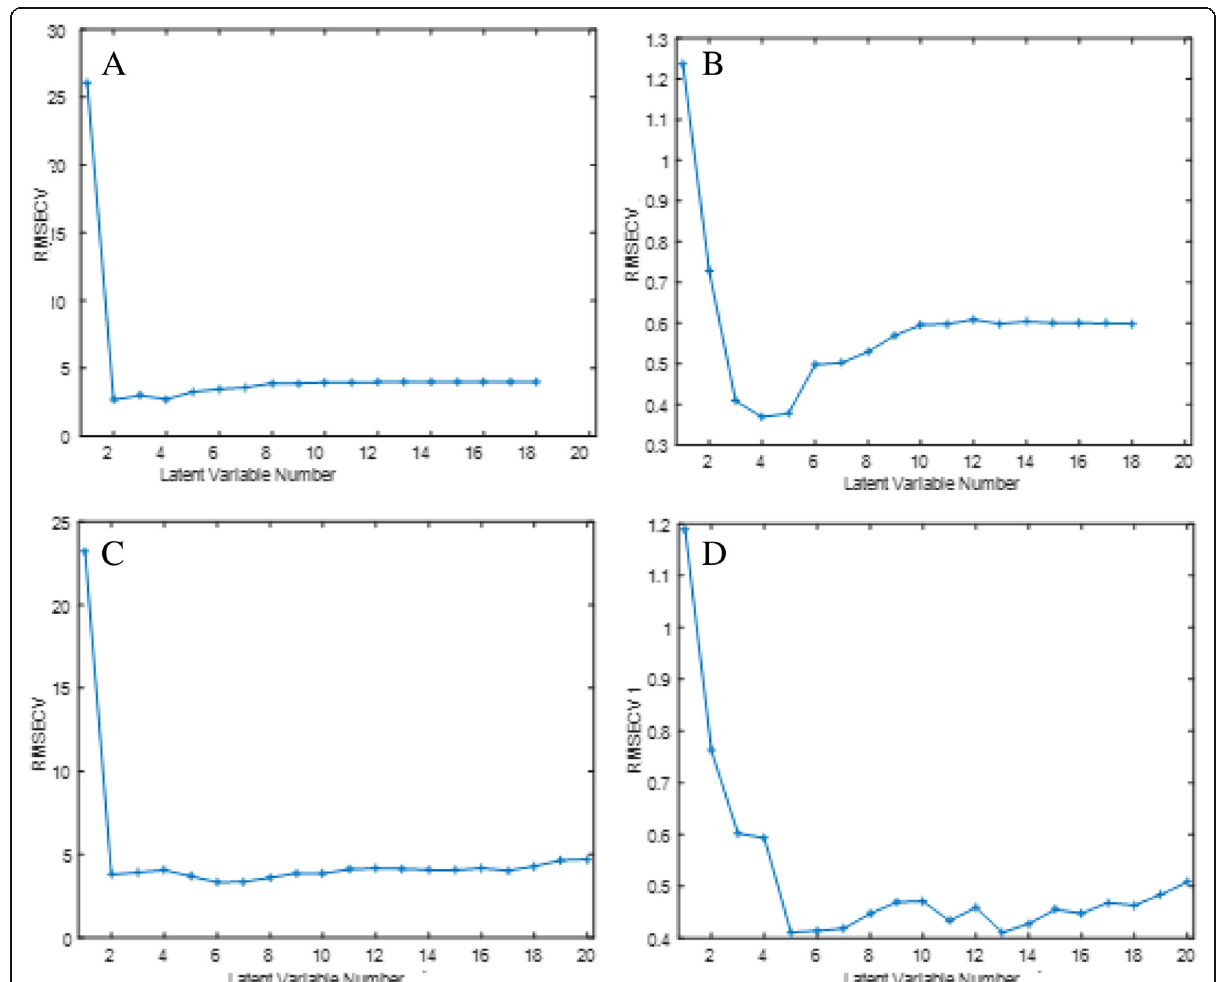
Fig. 3 RMSECV values versus latent variable number for the prediction of calibration set by using cross validation of ET-PLS ( a ), TC-PLS ( b ), ET-PCR ( c ), and TC-PCR ( d )